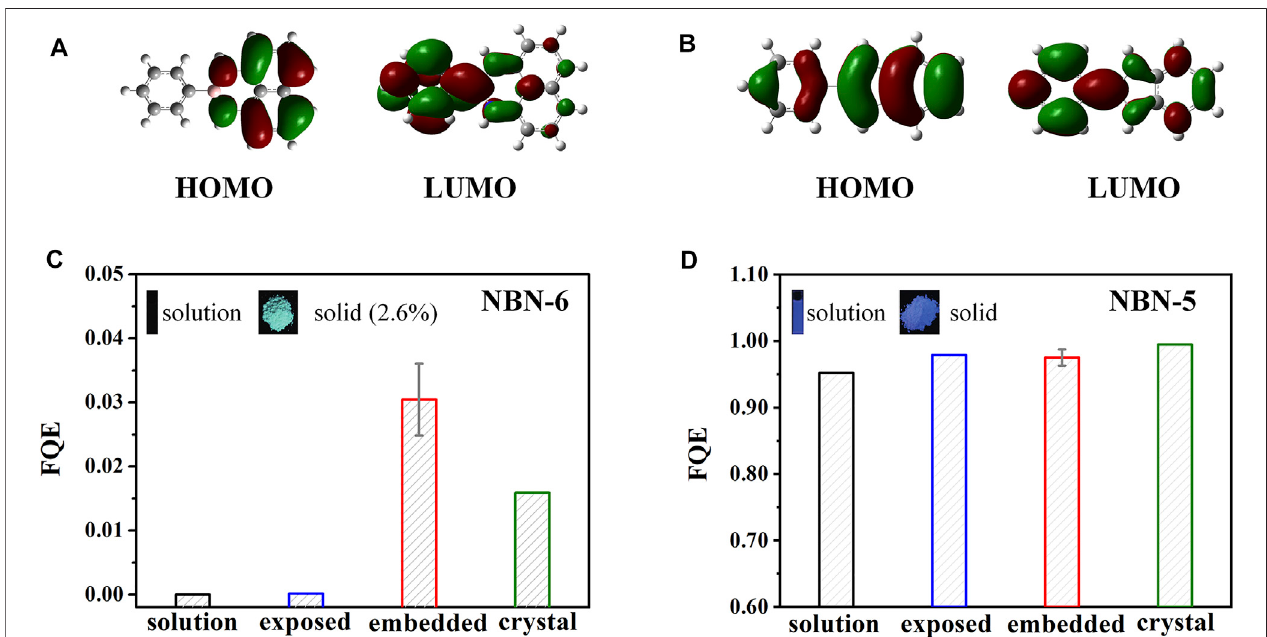
FIGURE4| ElectrondensitycontoursofHOMOandLUMOof (A) NBN-6and (B) NBN-5atS 0 geometryinmethanolsolution.TheFQEof (C) NBN-6and (D) NBN- 5 at different environments. (Reproduced with permission from (Zeng et al., 2021) Copyright 2021 The Royal Society of Chemistry).